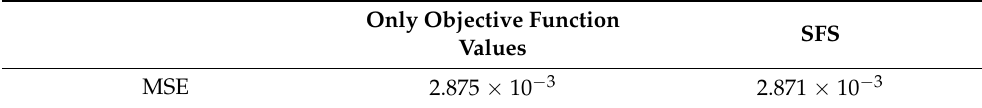
Table 6. MSE results of machine learning for large-scale problems for 2